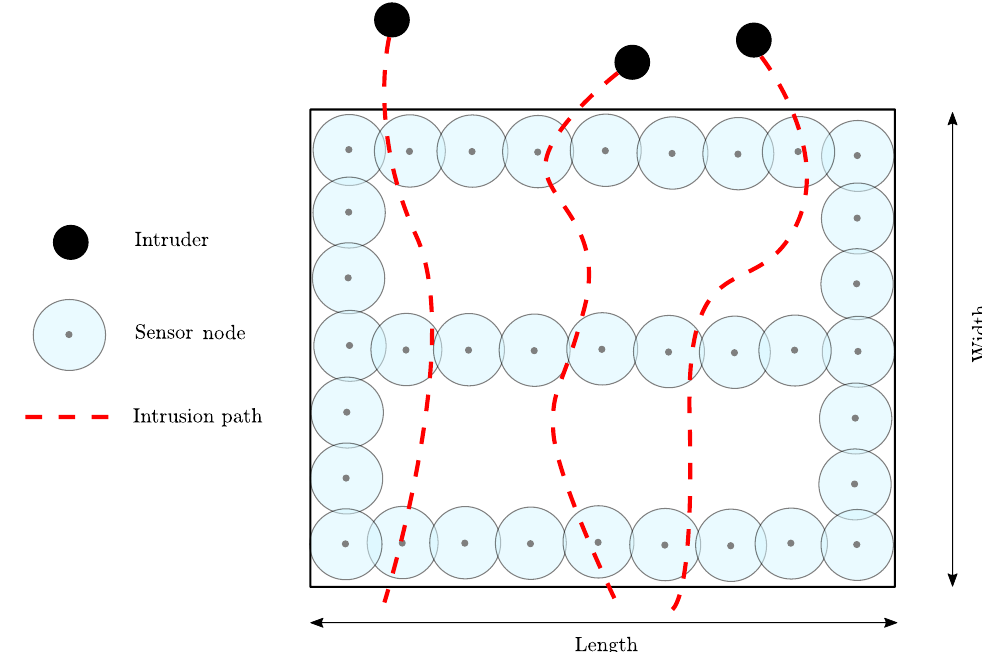
Figure 1. Illustration of 3-barrier coverage for each intrusion